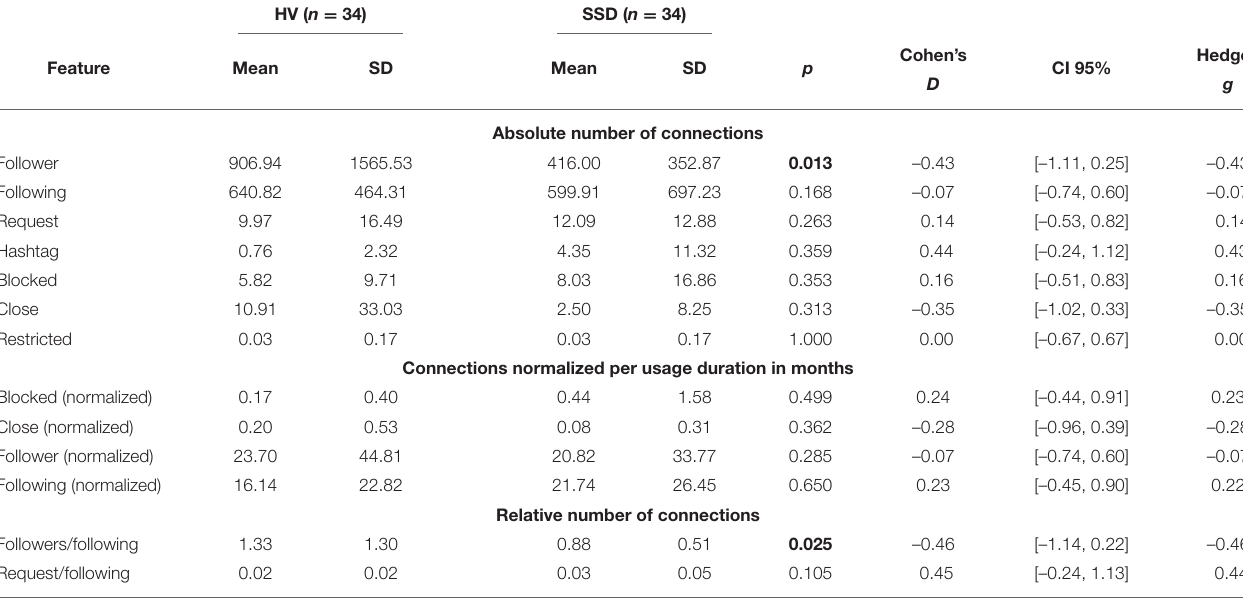
TABLE 4 | Statistics of network